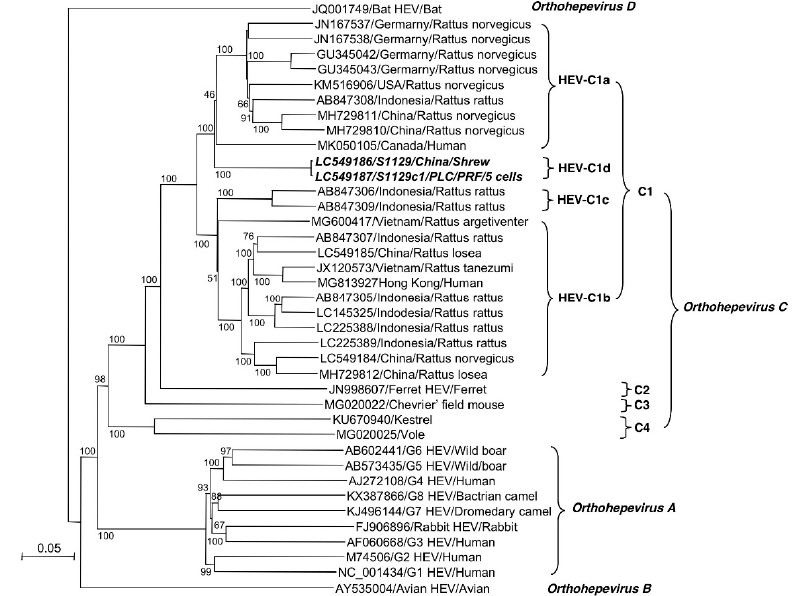
Figure 4. Phylogenetic analyses based on the entire genome. Phylogenetic trees with 1000 bootstrap replicates were generated by the neighbor-joining method based on the entire genome of HEVs. S1129 and S1129c1 detected in the present study are shown in bold italic letters.